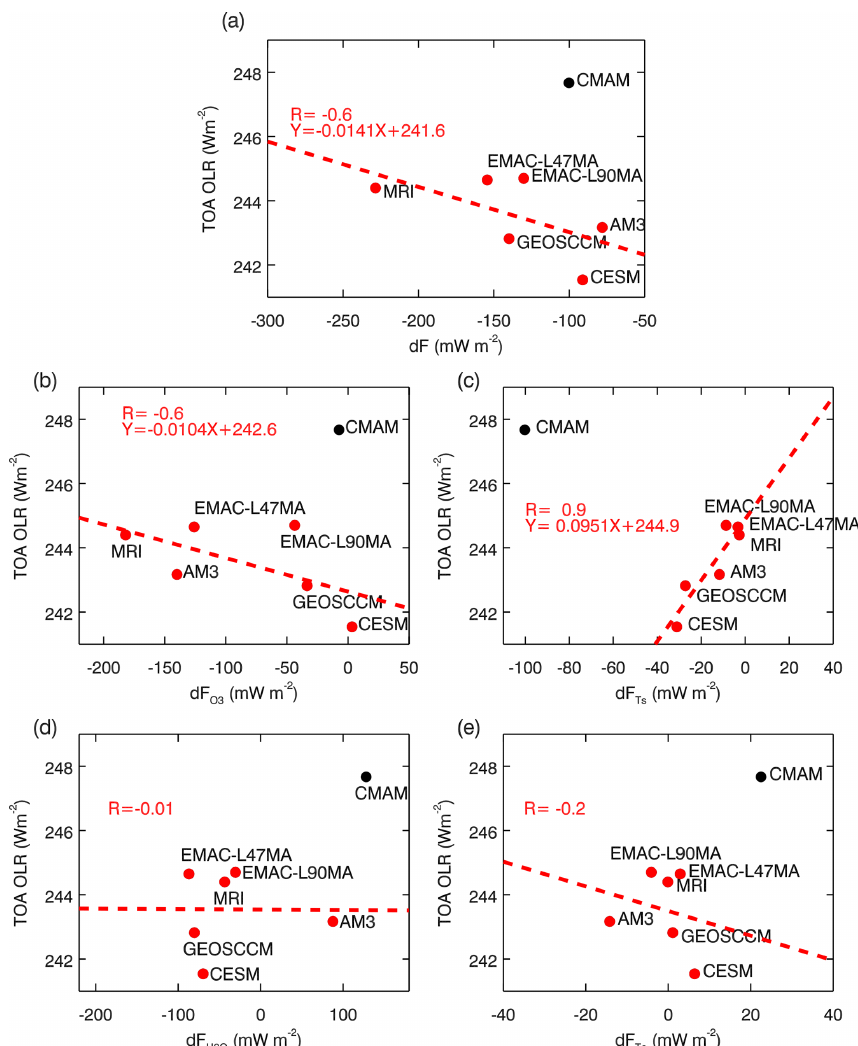
Figure 13. The correlation of the ozone band TOA flux biases to the model-calculated broadband OLR (a) and the correlation of the attributed radiative components to the broadband OLR (b–e)